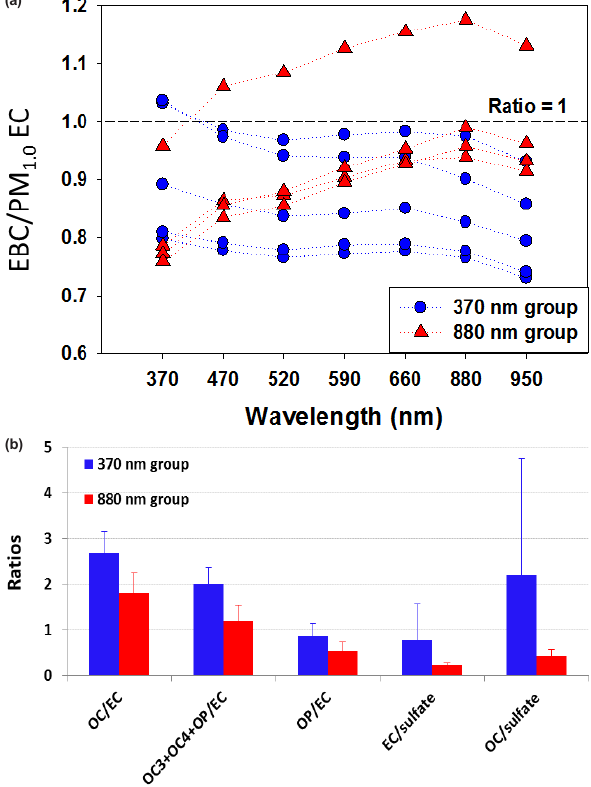
Figure 1. Comparison of the 370nm group with the 880nm group. (a) EBC / PM 1 . 0 EC ratios as a function of wavelength. (b) Ra- tios of OC / EC, OC3 + OC4 + OP / EC, OP / EC, EC / sulfate, and OC / sulfate in PM 1 . 0 . Ratios are shown as mean values and error bars indicate standard deviation (1 σ)